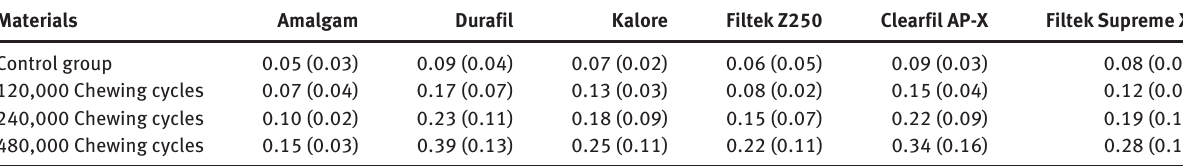
Table 3: Surface roughness ( μ m) of dental composite materials under different chewing cycles.